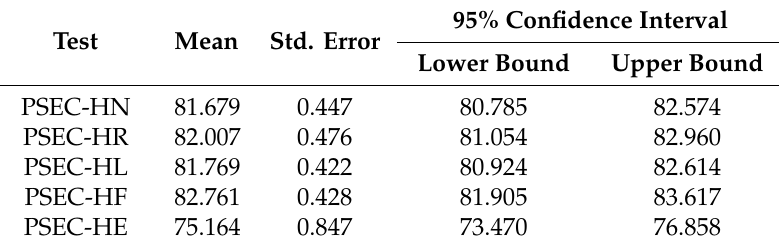
Table 8. Healthy controls’ postural stability scores with head